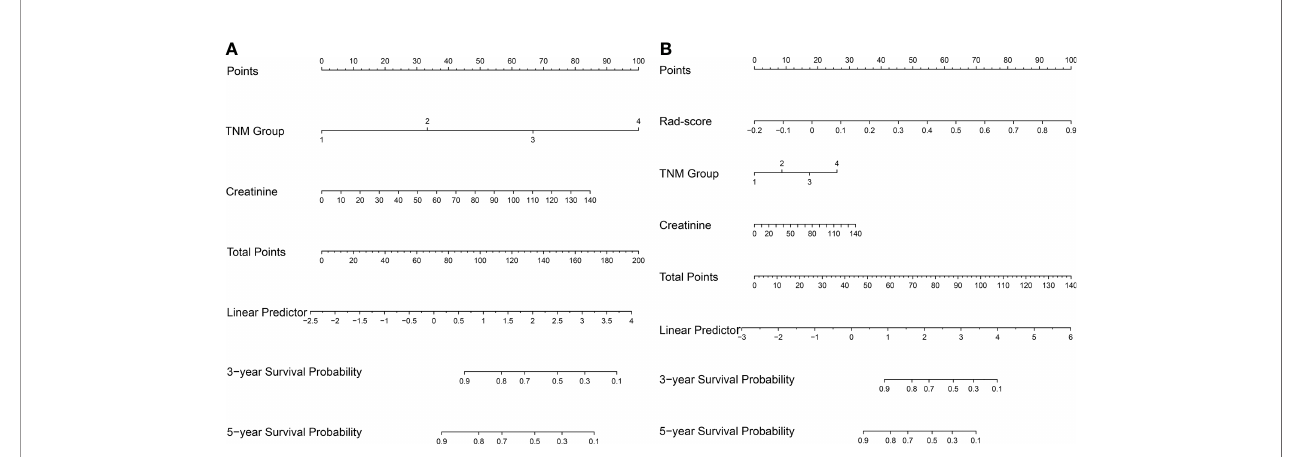
FIGURE 5 | The nomogram for survival estimation. The clinical nomogram (A) , combing TNM group and creatinine. The radiomics nomogram (B) , combing Rad-score, TNM group, and creatinine.